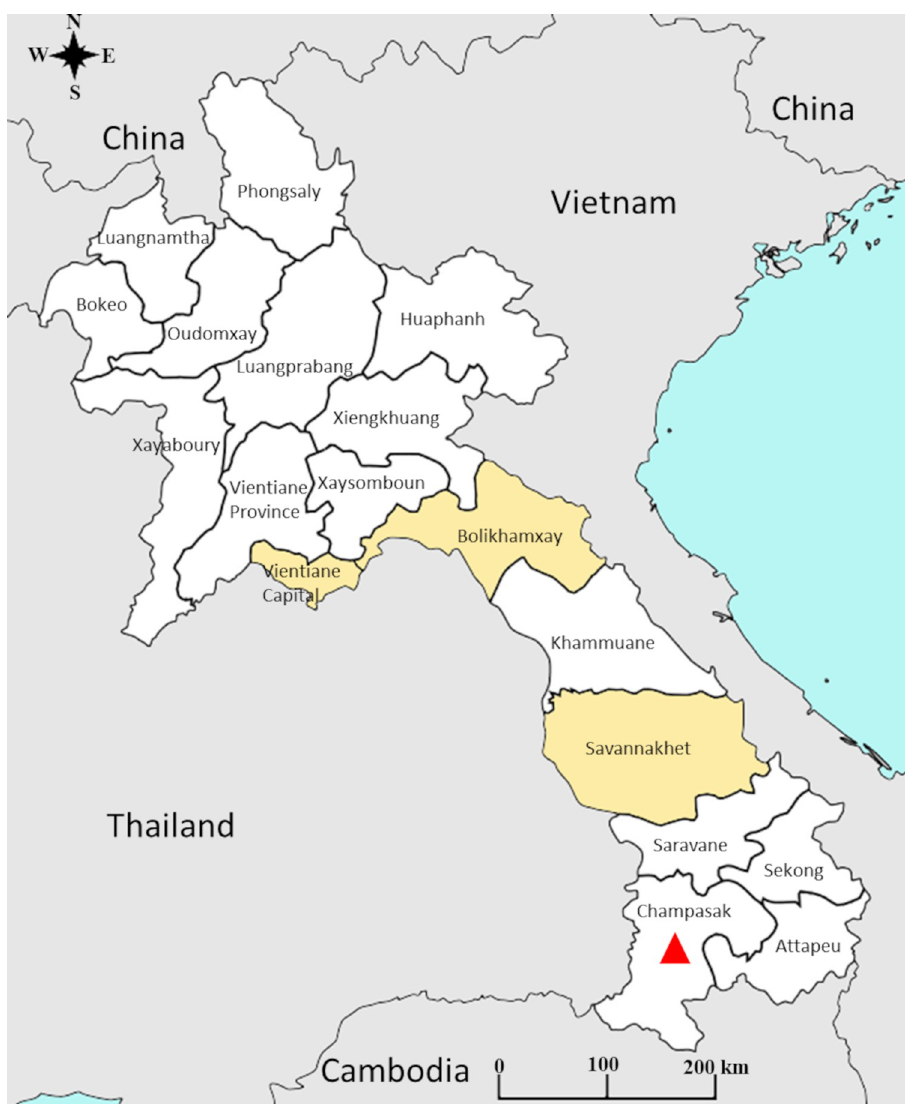
Fig 1. Geographical location of chikungunya cases, at the province level, in Lao PDR. Data based on the analysis of the samples collected by the Institut Pasteur du Laos arbovirus surveillance network between 2012 and 2020. The provinces indicated in yellow correspond to those where at least one sample was found positive for chikungunya virus during the study period (2014–2020). The red triangle indicates the province where the chikungunya outbreak occurred in